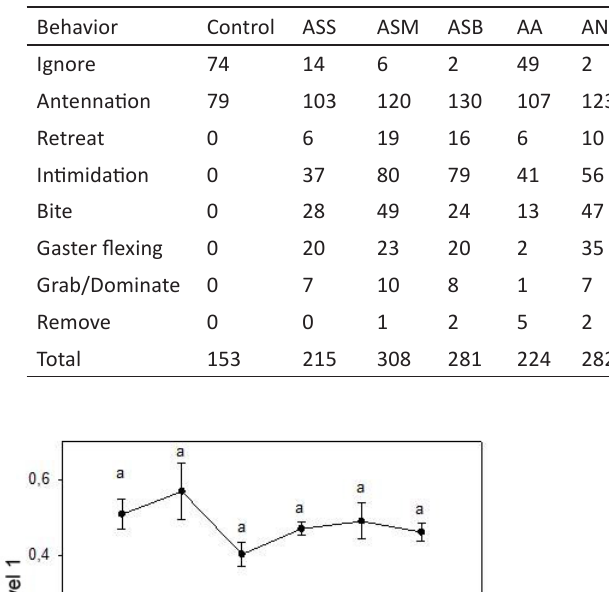
Table 1. Observed behaviors during the interactions among workers of A. subterraneus subterraneus and conspecific nestmates (Control), conspecifics of colony collected in the field (ASS), workers of A. subterraneus molestans (ASM), A. subterraneus brunneus (ASB), queens of A. ameliae (AA) or workers of A. niger (AN).